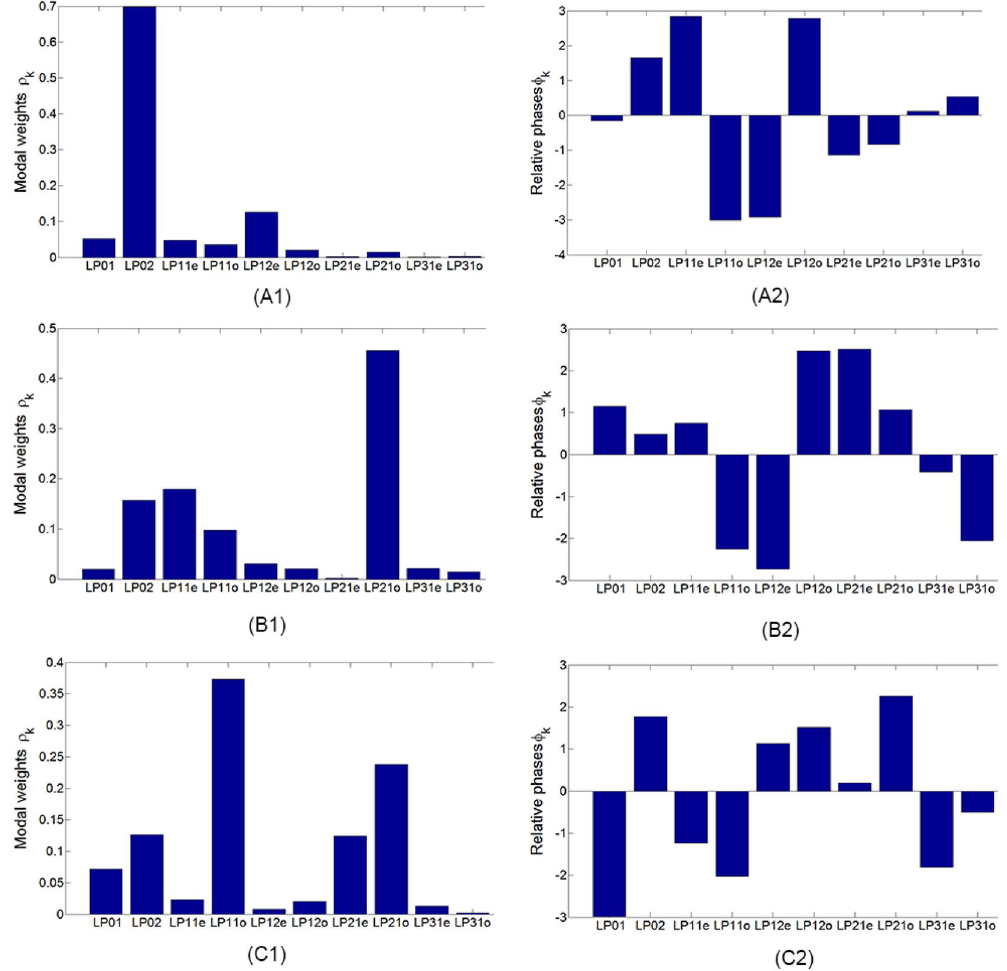
Figure 3. The modal coefficients of the communication fiber. ( A1 , B1 and C1 ) The modal weights ρ k . ( A2 , B2 and C2 ) The relative phases φ k